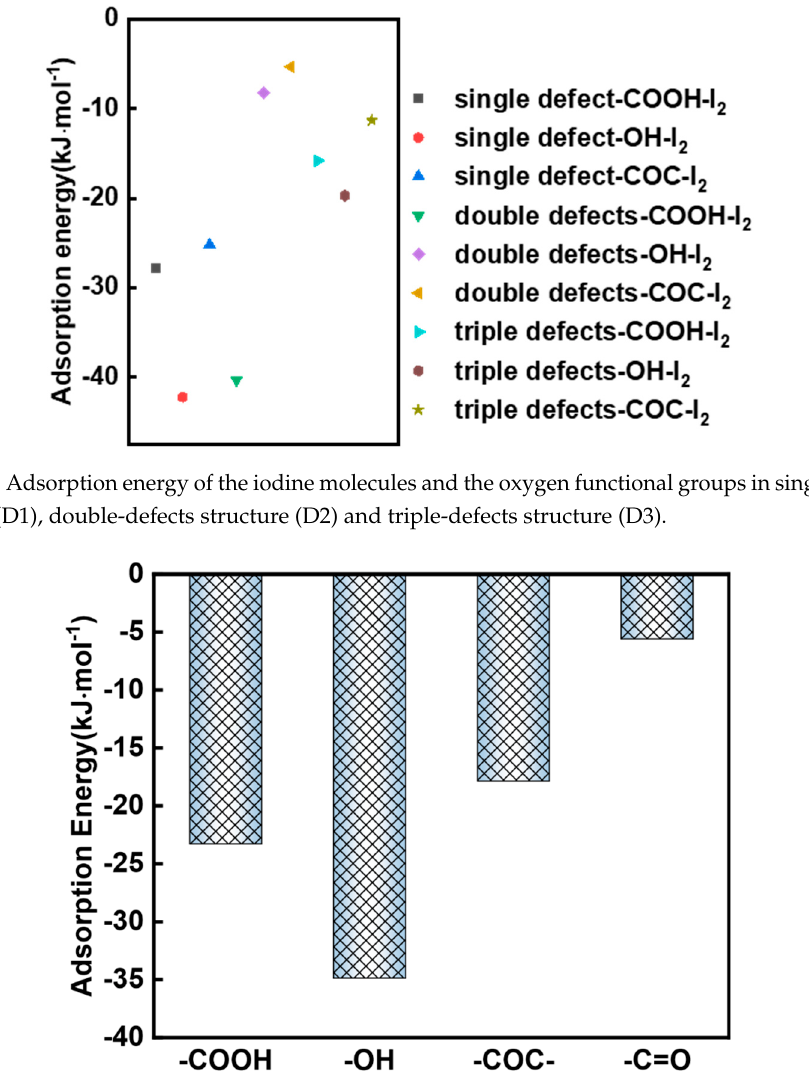
Figure 11. Average adsorption energy of different oxygen functional groups.